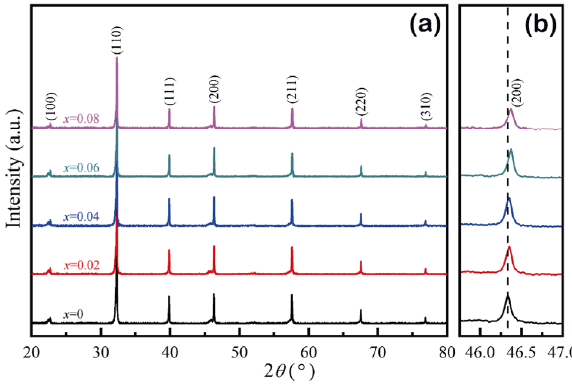
Fig. 1 XRD patterns of BNS 0.245 − 1.5 x (cid:0) 0.5 x B 0.325+ x T ceramics: (a) 2 θ = 20°–80° and (b) 2 θ =